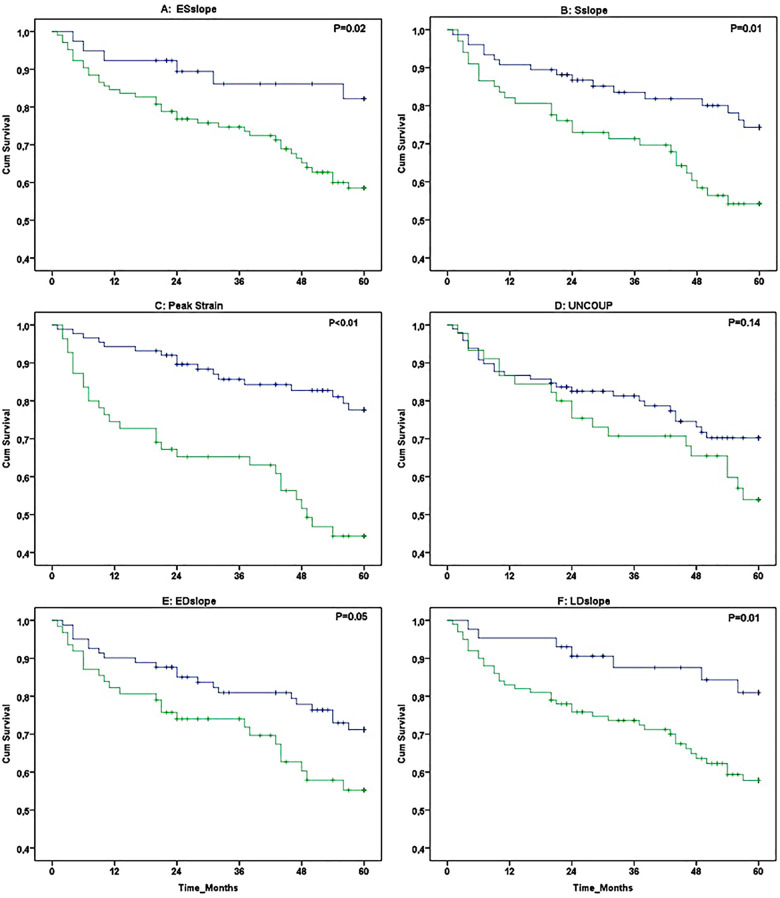
Kaplan–Meier survival curves (5-year follow-up) in 143 PH patients for individual characteristics of the RV ϵ-area loop that were categorized into low risk (blue line) and high risk (green line). The following loop characteristics were presented: ESslope (A), Sslope (B), peak strain (C), Uncoup (D), EDslope (E), and LDslope (F).